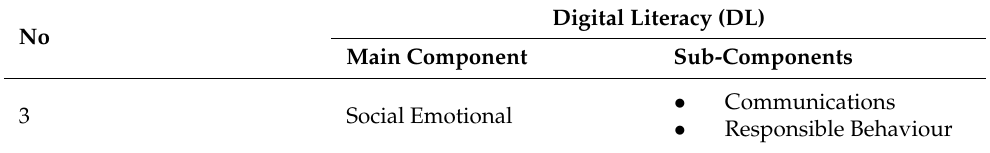
Table 3. Social Emotional